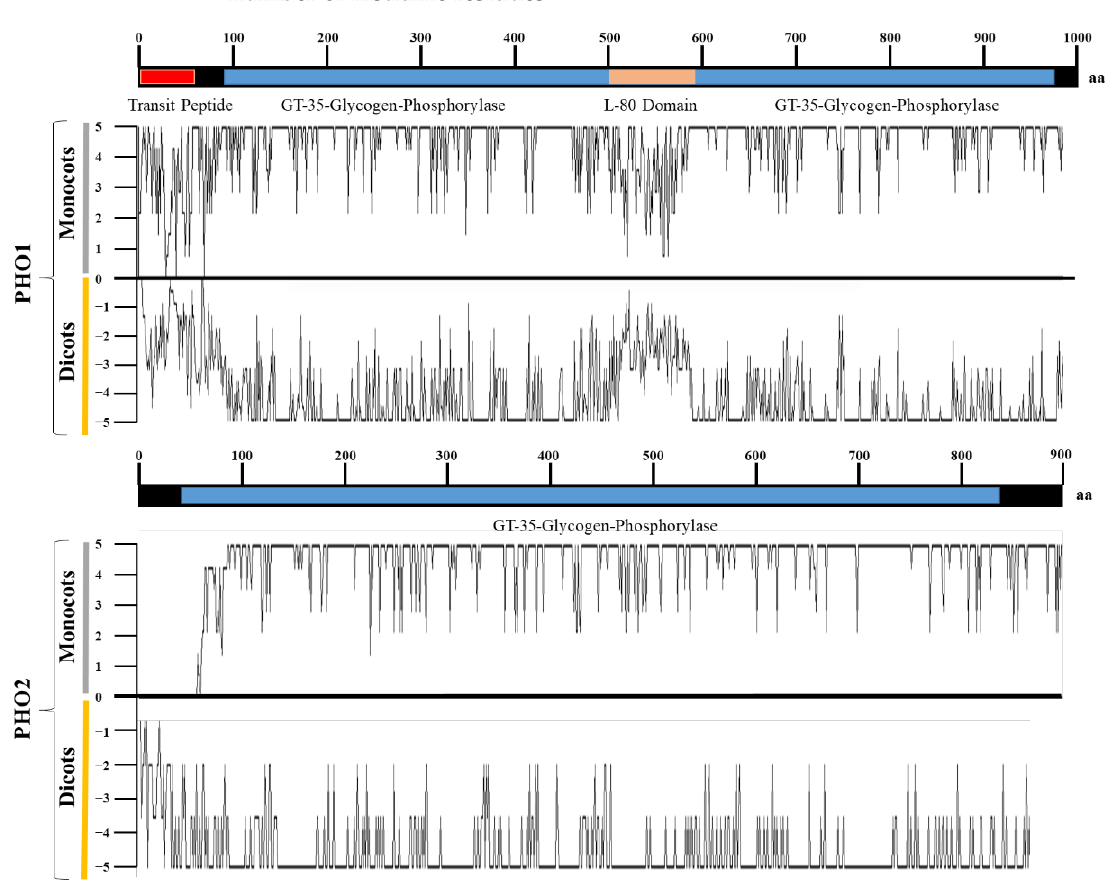
Figure 4. Amino acids sequence similarity of PHO1 and PHO2 among various monocots and dicots with respect to the consensus sequence. A value position of zero indicates the consensus sequence. Similar amino acids are plotted on scales 1 – 5 in monocots and − 1 to − 5 in dicots.